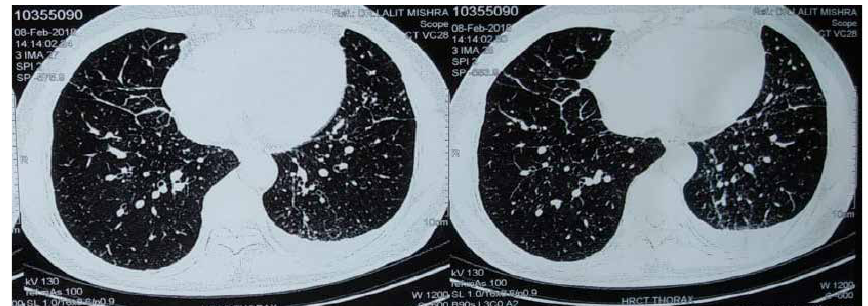
Figure 1: Contrast enhanced computed tomography of chest.